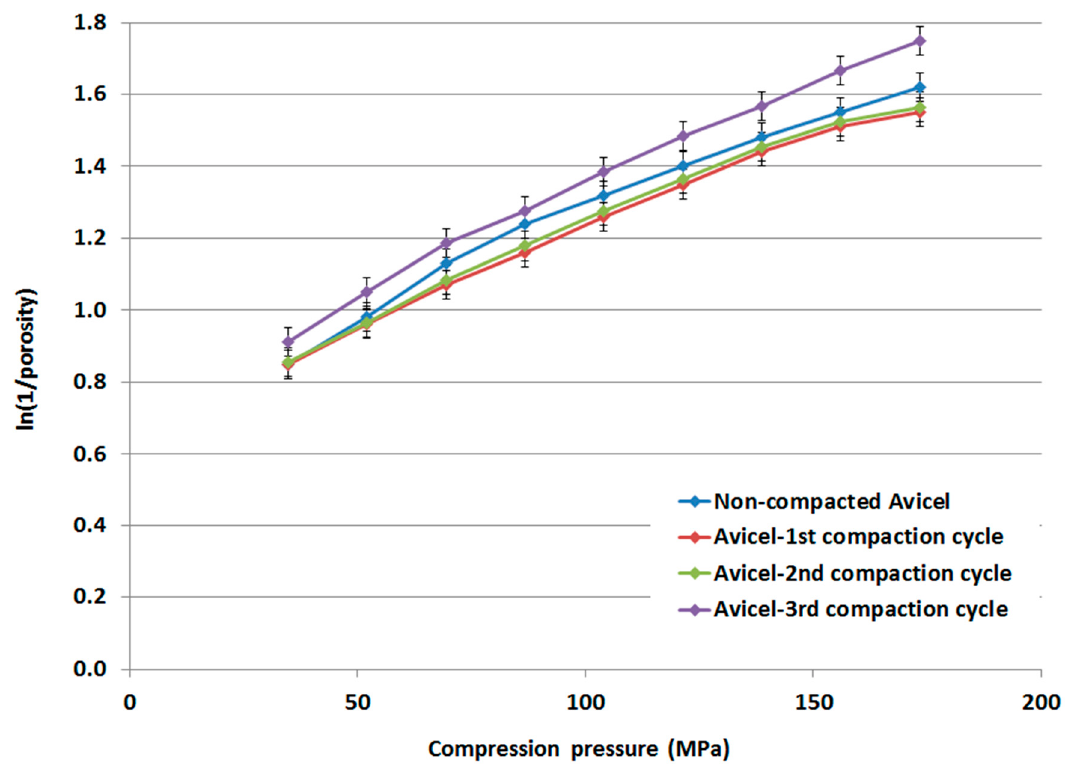
Figure 10. Heckel plot of non-compacted and compacted Avicel PH-101.